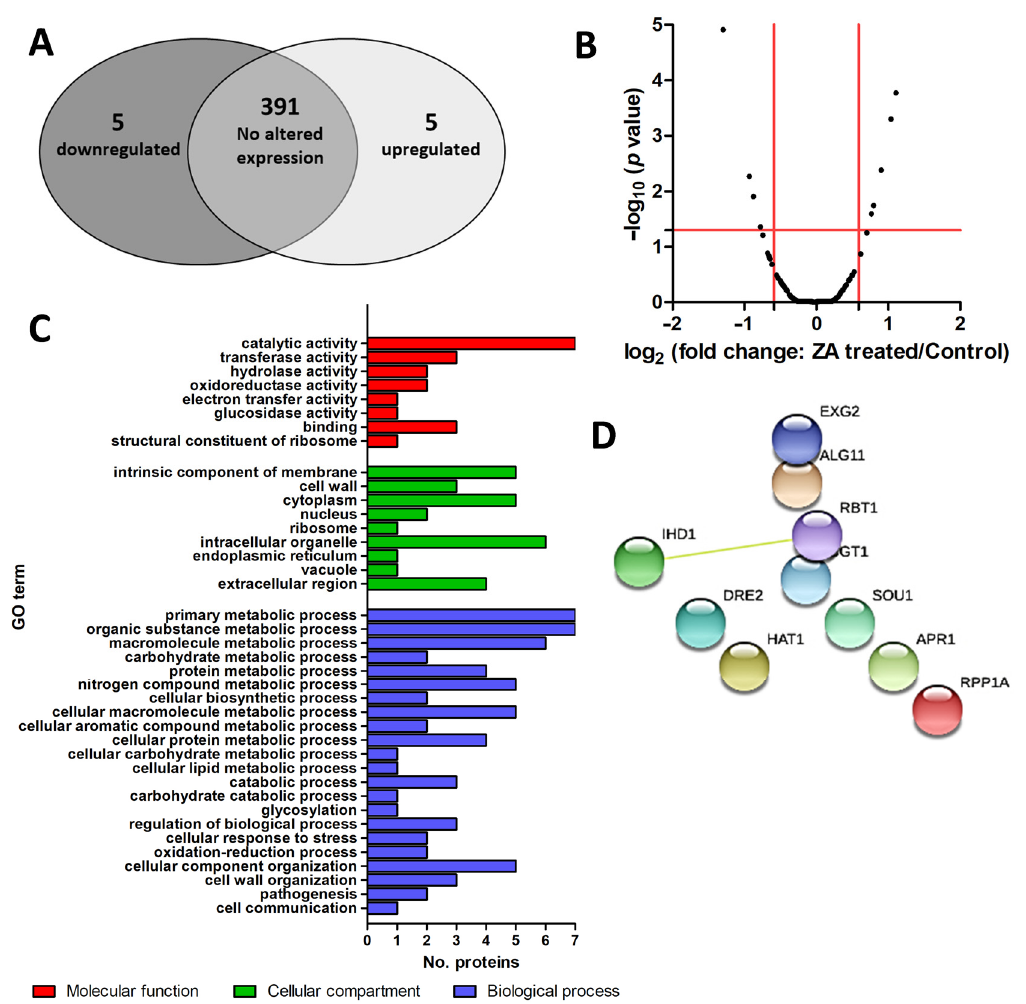
Figure 3. Venn diagram, Volcano plot, Panther Gene Ontology (GO)-slim functional analysis and String analysis of proteins differentially expressed in C. albicans biofilms upon 10 mg/L ZA treatment. ( Panel A ): Venn diagram with proteins significantly (a ± 1.5-fold change) and not significantly different in abundance between the control and treated samples. ( Panel B ): Volcano plot displaying the − log 10 ( p value) plotted against the log 2 (fold change: treated/control). Points above the non-axial horizontal line represent proteins with significantly different abundances ( p < 0.05). Points to the right of the right-most non-axial vertical line display protein with fold changes of treated/control ratio higher than 1.5, while points to the left of the left-most non-axial vertical line display protein with fold changes of treated/control ratio less than − 1.5. ( Panel C ): Panther GO functional classification of proteins significantly upregulated and downregulated in the biofilm upon ZA treatment (molecular function: red; cellular compartment: green; biological process: blue). Second-level GO categories are reported. ( Panel D ): String analysis showing the predicted protein–protein interaction networks. Query proteins and first shell of interactor are reported.